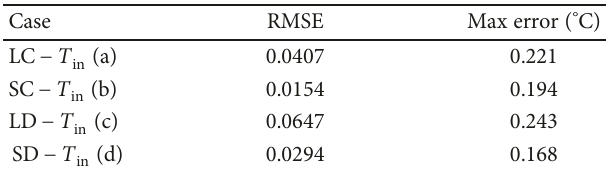
LC − T SC − T LD − T SD − T in ; (b) in ; (c) in ; (d) in . Table 7: Estimation errors for four validation data by combining the RBF NN and